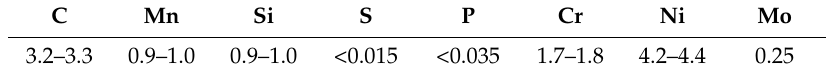
Table 1. Chemical composition ranges of the outer ring layers expressed in weight percent (wt